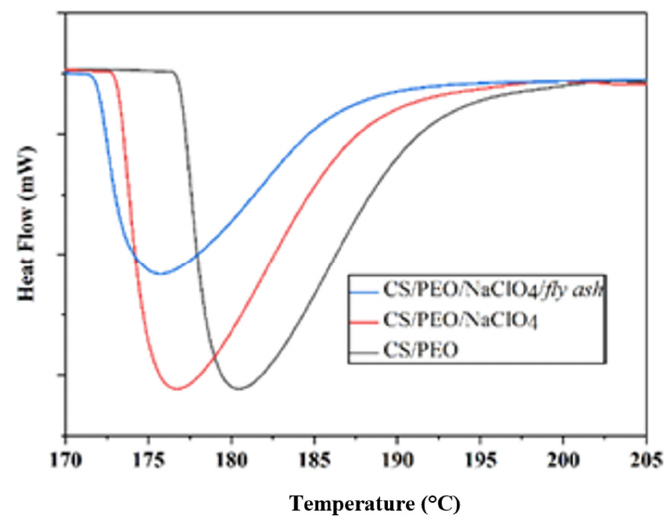
Figure 4. XRD diffractogram of SPE.